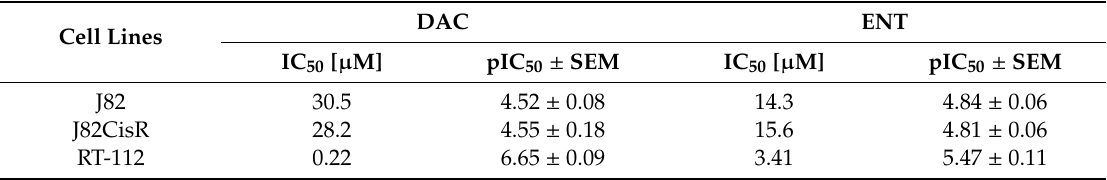
Table 1. Summary of the IC 50 and pIC 50 [-log IC 50 ] values of DAC and ENT in J82, J82CisR, and RT-112 cells (72 h